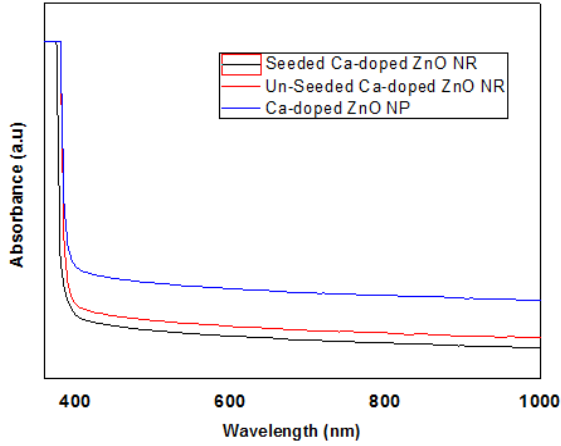
Figure 10. UV‐Vis absorption graph of Ca‐doped ZnO nanoparticles, unseeded nanorods, and seeded nanorods.